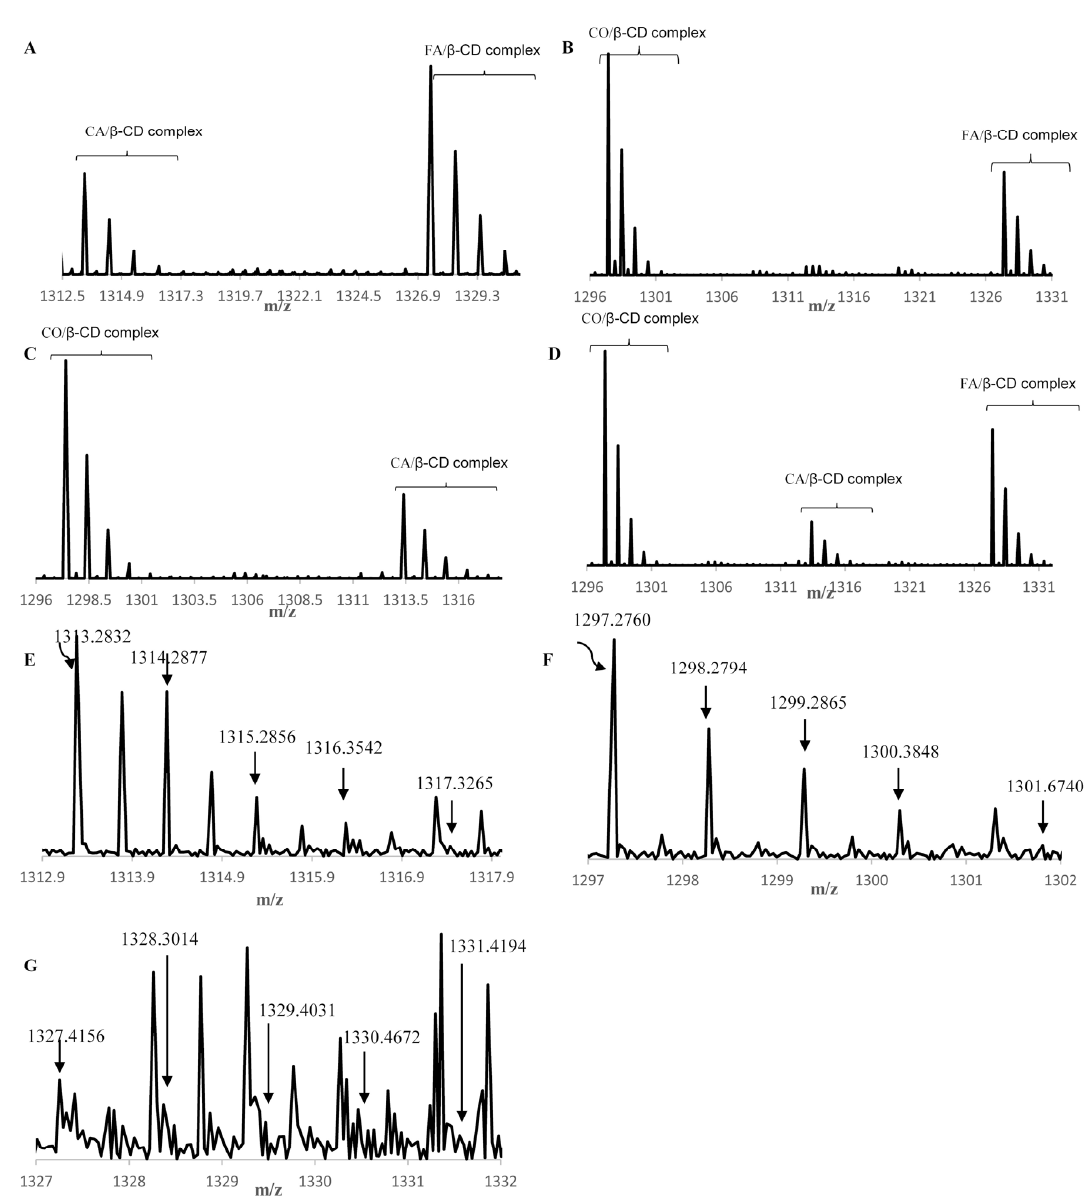
Figure 2. MS spectra: ( A )caffeic acid, trans ‐ ferulic acid, and β ‐ cyclodextrin mixture, ( B ) p ‐ coumaric acid, trans ‐ ferulic acid and β ‐ cyclodextrin mixture, ( C ) p ‐ coumaric acid, caffeic acid, and β ‐ cyclodextrin mixture, ( D ) p ‐ coumaric acid, caffeic acid, trans ‐ ferulic acid and β ‐ cyclodextrin mixture, ( E ) extract in the range 1312.0 and 1317.0 m / z —caffeic acid/ β ‐ cyclodextrin ‐ complex, ( F ) extract in the range 1297 and 1302 m / z — p ‐ coumaric acid/ β ‐ cyclodextrin ‐ complex, and ( G ) extract in the range 1327 and 1332 m / z —trans ‐ ferulic acid/ β ‐ cyclodextrin ‐ complex. In the synthetic mixture ‐ CA, FA, β ‐ CD, both complexes were formed in different amounts. The amount of the FA/ β ‐ CD ‐ complex was higher than the CA/ β ‐ CD ‐ complex. In the synthetic mixture ‐